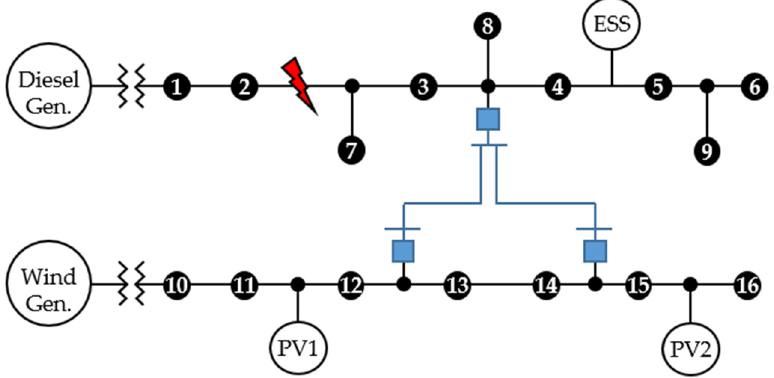
Figure 12. An example system for the case study.